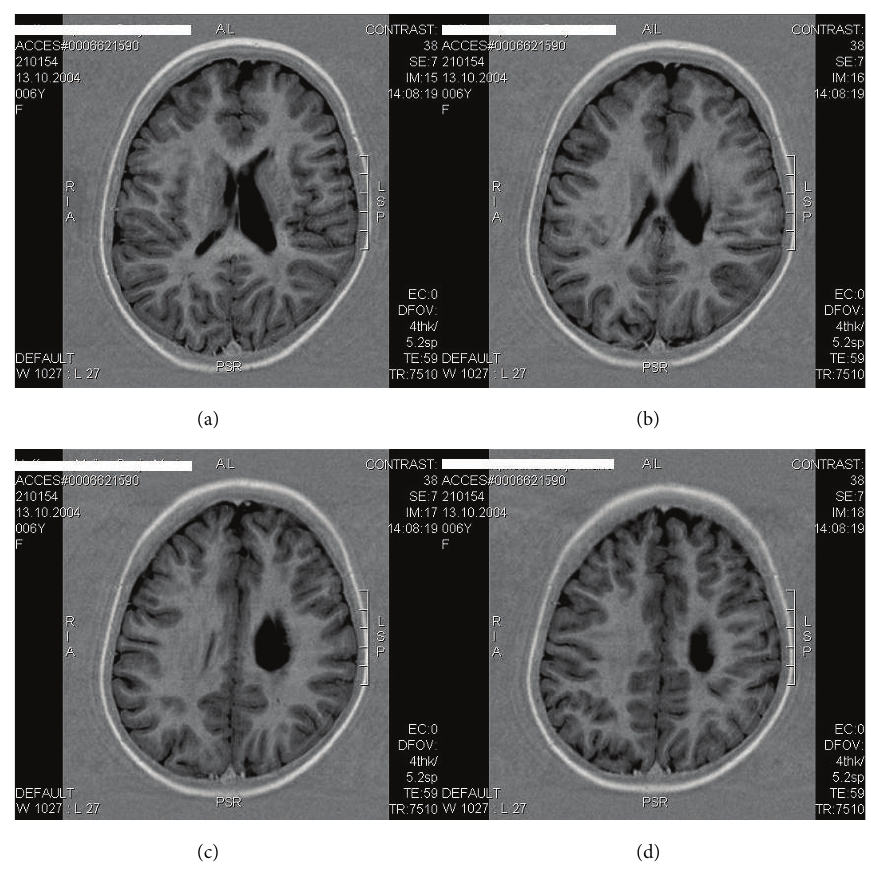
Figure 6: MRT of the brain (M.H.) at 7 years of age (2011). Left arterial ischemic stroke in the central and paraventricular white matter resulting in a porencephalic cyst and enlarged lateral ventricle. The estimated total white matter loss amounted to approximately 20% (1.5- Tesla, head coil array, T1w TSE